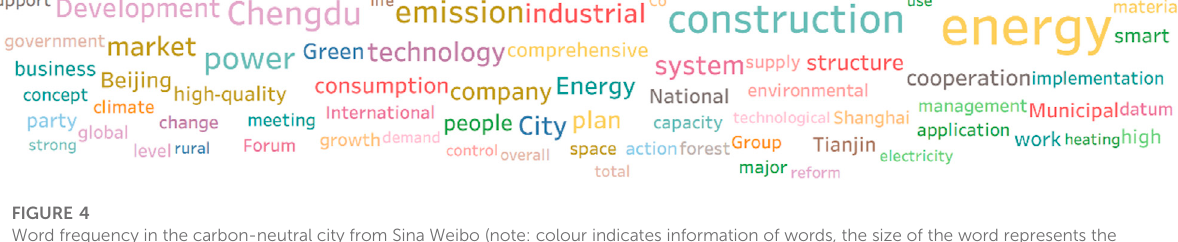
Word frequency in the carbon-neutral city from Sina Weibo (note: colour indicates information of words, the size of the word represents the keyword